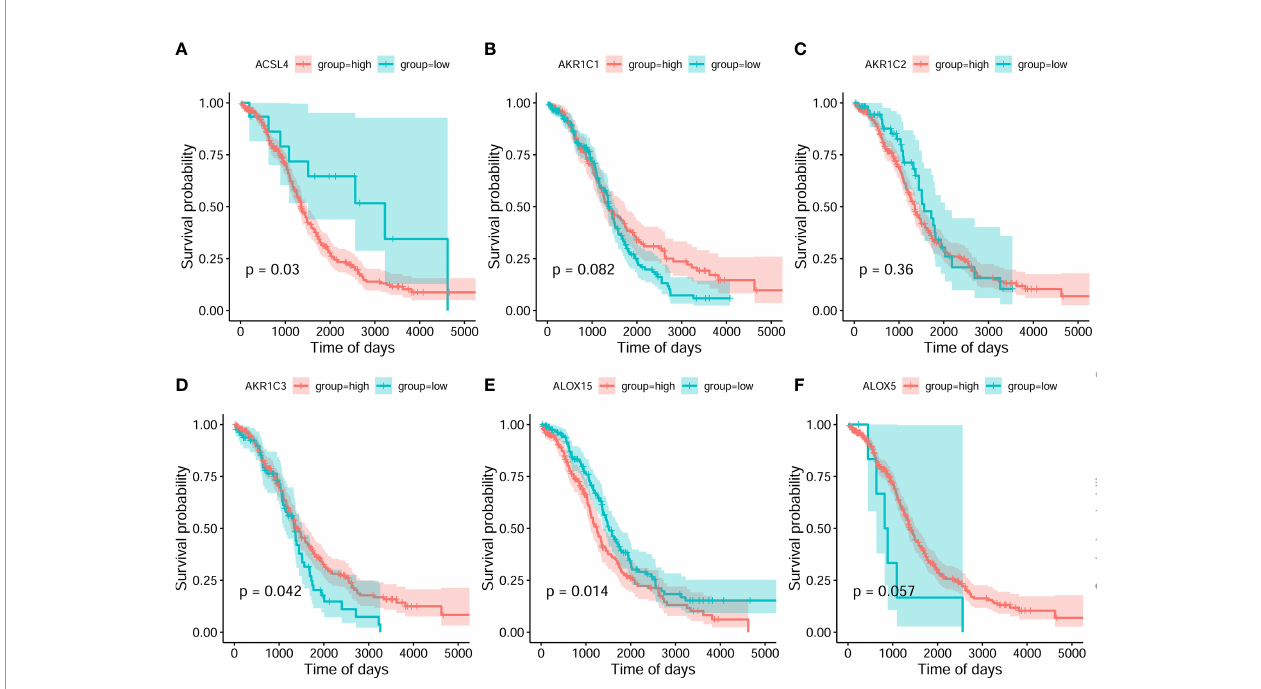
FIGURE 2 | Classi fi cation analysis for 6 ferroptosis-related gene expression and overall survival curve in the OC gene dataset of the Cancer Genome Atlas. (A) ACSL4 (B) AKR1C1 (C) AKR1C2 (D) AKR1C3 (E) ALOX15 (F)